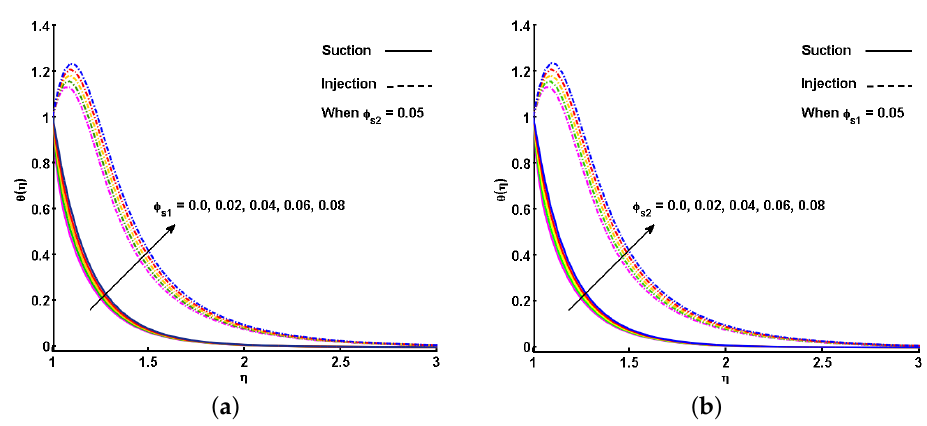
Figure 8. Effect of volume fraction of nanoparticles ( φ s 1 and φ s 2 ) on temperature profile ( θ ( η )) ( a ) φ s 1 is varied and φ s 2 is fixed; ( b ) φ s 1 is fixed and φ s 2 is